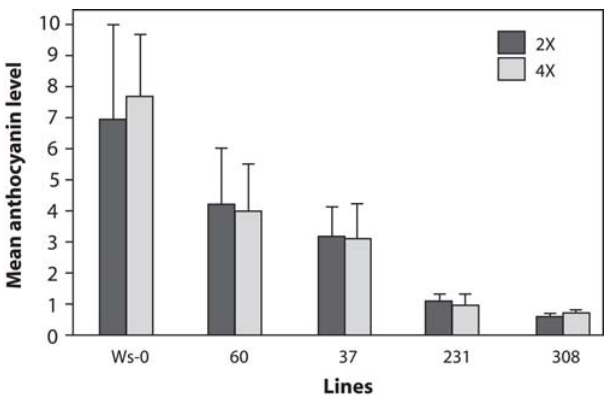
Figure 3. Anthocyanin quantification in transgenic plants, compared to wild-type Ws-0. Anthocyanin levels (Y axis) are expressed as the mean of OD530 readings for 9 biological replicates. Genotype is indicated on the X-axis. Error bars indicate the standard deviation. In the legend: 2x is diploid, 4x tetraploid.